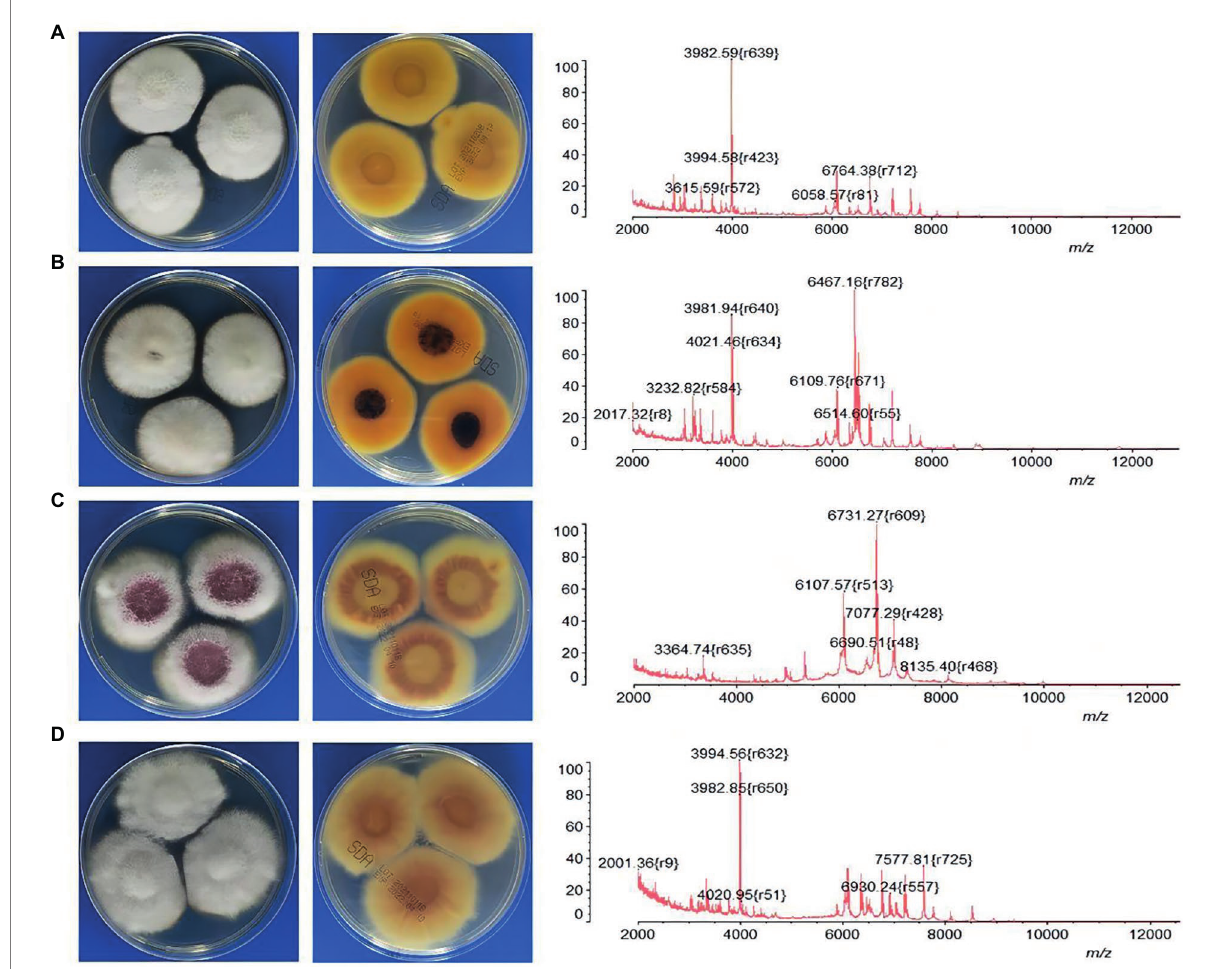
FIGURE 2 The characteristics of MALDI-TOF MS profiles corresponding to the morphologies of four common Fusarium species. (A) F. keratoplasticum ; (B) F. falciforme ; (C) F. proliferatum ; (D) F. oxysporum